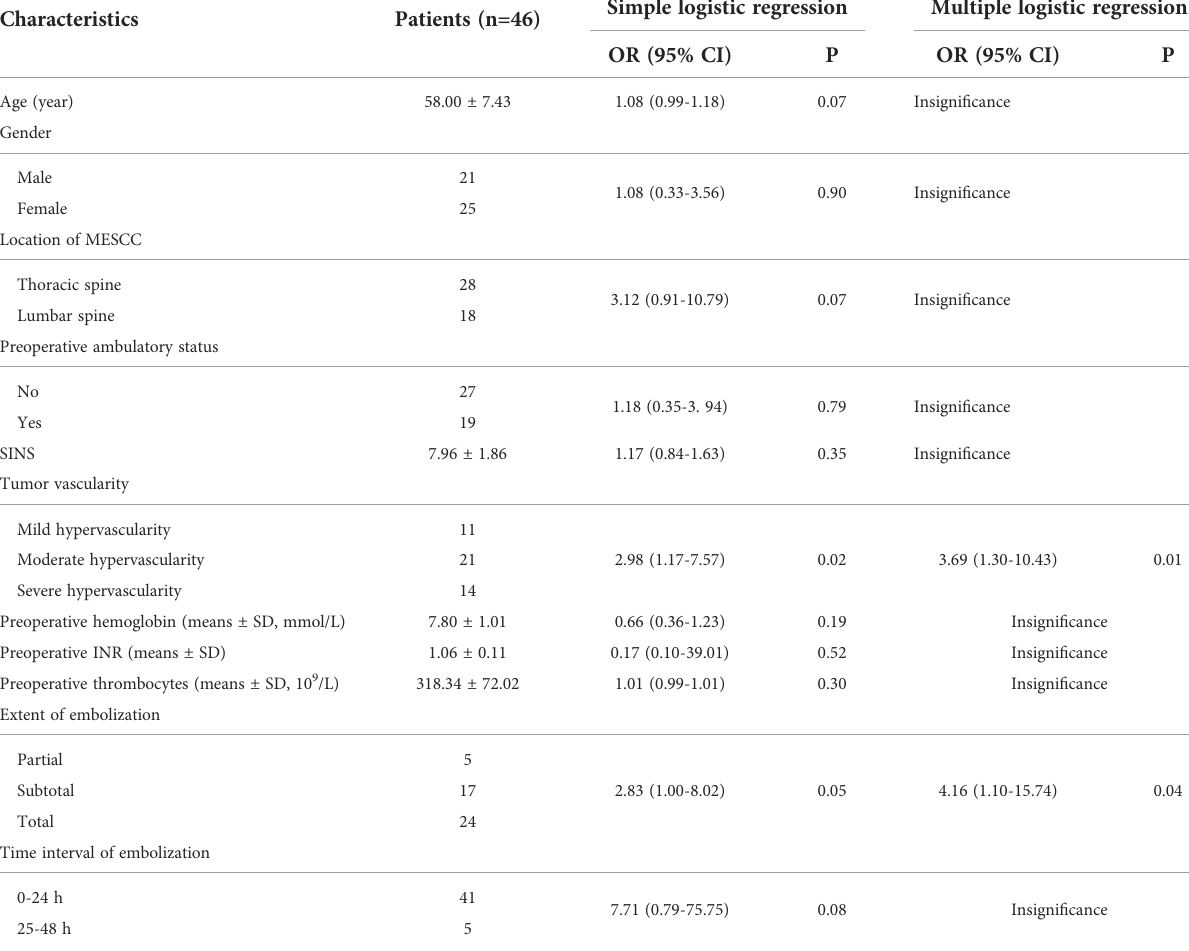
TABLE 3 Univariate and multivariate analysis of characteristics for predicting blood loss among patients treated with preoperative embolization.